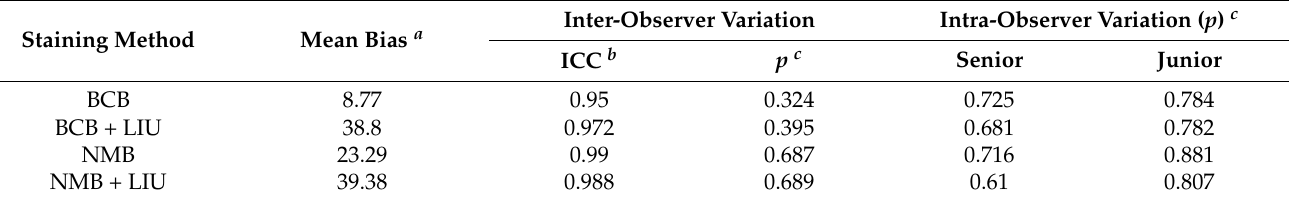
Figure 3. Box plot showing the distribution of differences in reticulocyte counting between the automated analyzer and four different supravital staining approaches, showing the minimum and maximum values as well as the first (lower), second (median), and third (upper) quartiles. Small crosses denoting mean values. BCB—brilliant cresyl blue; NMB—new methylene blue; LIU—Liu’s stain. Table 1. Bias in reticulocyte enumeration with four staining methods compared with automated counting and inter-/intra-observer